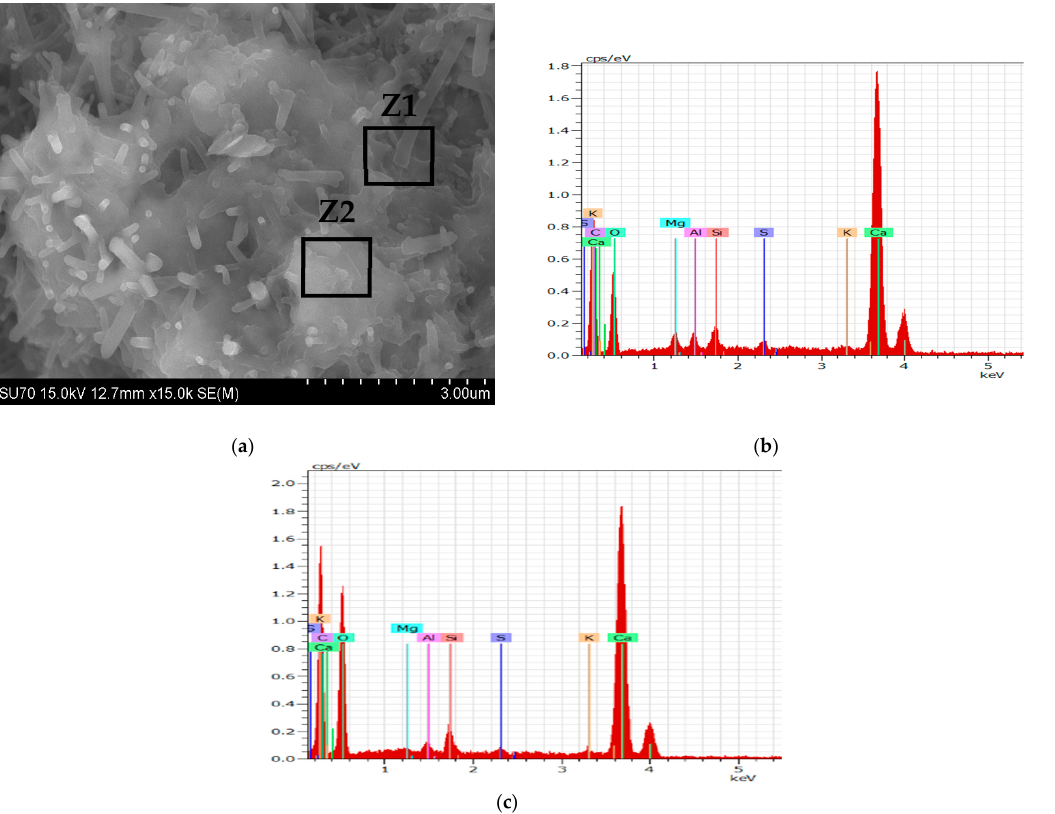
Figure 4. SEM micrograph of 1_NHL mortar. ( a ) with EDS spectra for Z1 ( b ), and Z2 ( c ).